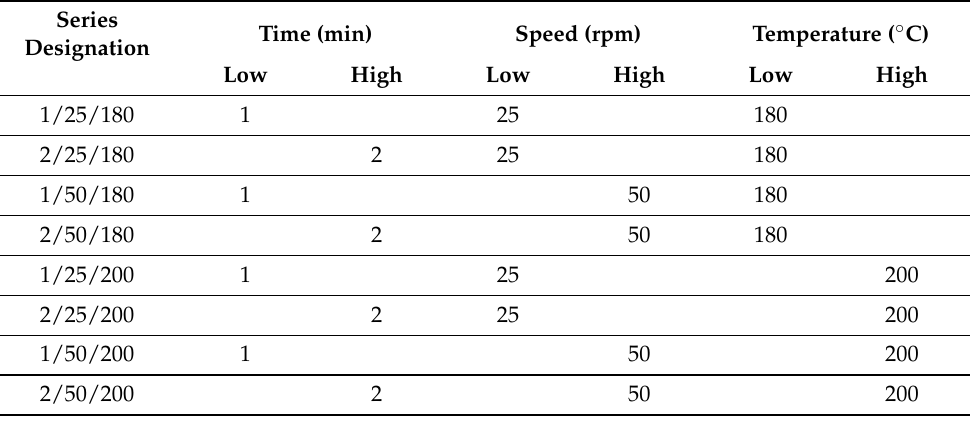
Compounding parameters to prepare biocomposites from 70 wt.% PLA/20 wt.% TMP/10 wt.%